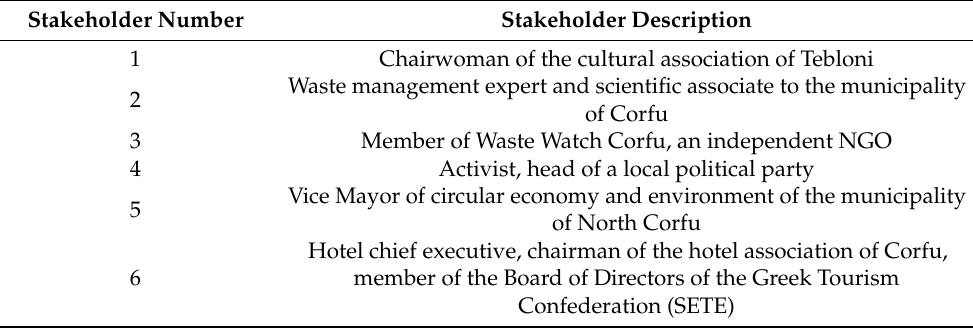
Table A1. Full list of stakeholders that participated in the